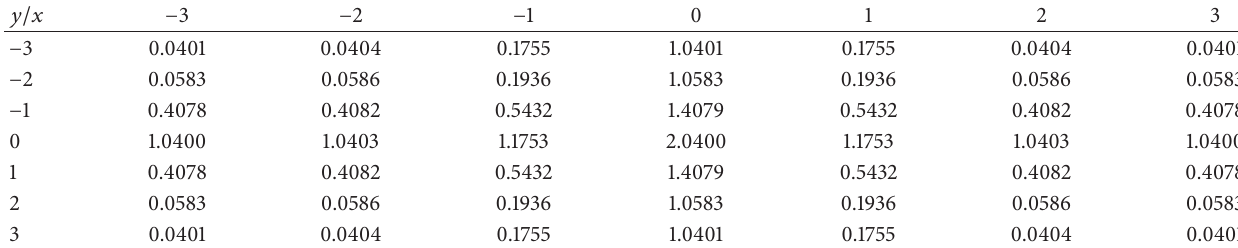
Table 5: Positive surface data from function 𝐹 3 (𝑥,𝑦) .